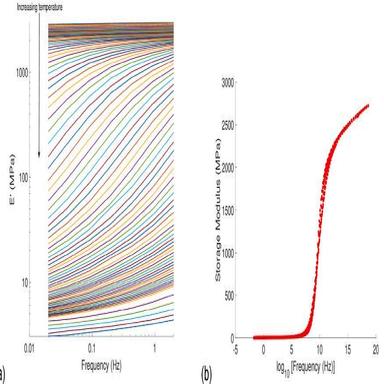
(a) Isotherms from the DMA results for U-NR and (b) the master curve generated by shifting these at a reference temperature of 25 ◦C.